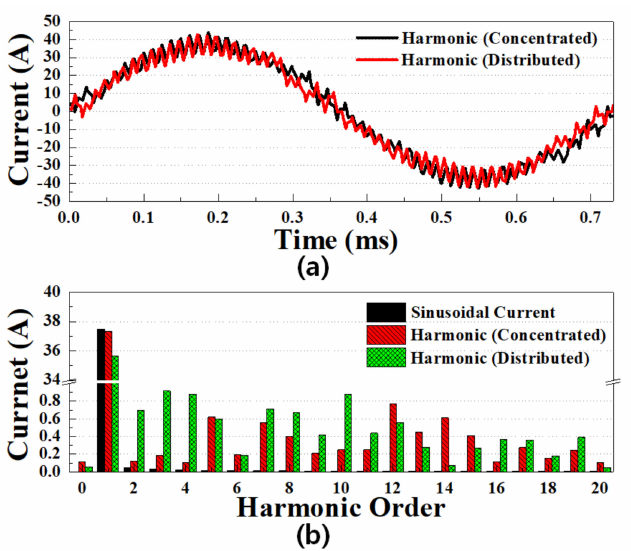
Figure 7. ( a ) Phase current waveforms and ( b ) harmonic components according to currents.